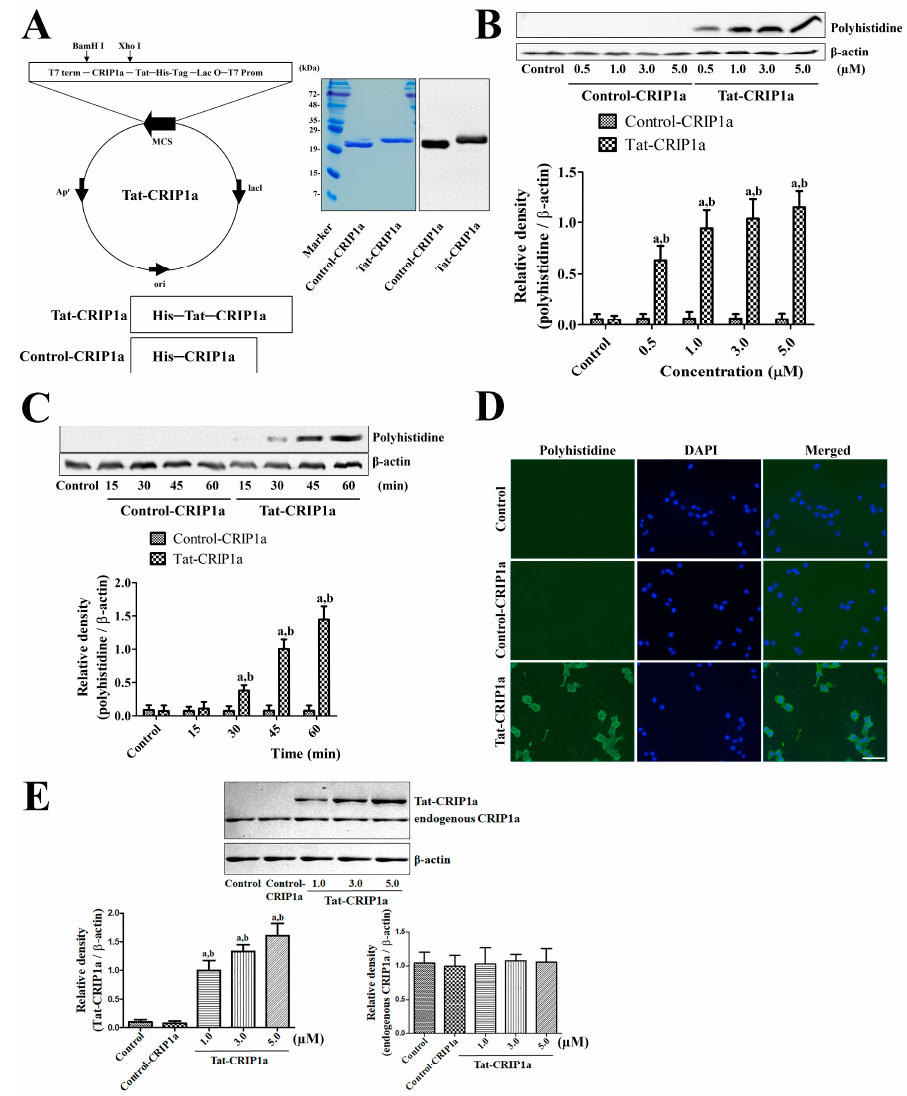
Figure 1. Construction of the control and Tat-CRIP1a fusion proteins and confirmation of e ffi cient delivery into HT22 cells. ( A ) Expression and purification of the His-CRIP1a and Tat-His-CRIP1a proteins were confirmed by Coomassie brilliant blue staining and Western blot analysis with an anti-polyhistidine antibody. ( B ) The delivery of exogenous His-CRIP1a and Tat-His-CRIP1a proteins in various concentrations was evaluated by Western blot for polyhistidine at 60 min after the treatment. ( C ) Time-dependent delivery of 1 µ M His-CRIP1a and Tat-His-CRIP1a proteins was confirmed by Western blot for polyhistidine. Bar graph represents the mean with standard deviation. ( B ) and ( C ) Density of polyhistidine and β -actin bands were analyzed and the data were calibrated using a ratio of polyhistidine / β -actin. A two-way ANOVA test was used to analyze the data followed by a Bonferroni’s post-hoc test ( a p < 0.05, significantly di ff erent from the Control-CRIP1a group; b p < 0.05, significantly di ff erent from the Control group). Data are expressed as mean with standard deviation. ( D ) Visualization of internalized His-CRIP1a and Tat-His-CRIP1a proteins with immunocytochemical staining for polyhistidine at 60 min after treatment. Scale bar = 50 µ m. ( E ) Penetration of exogenous Tat-CRIP1a and expression of endogenous CRIP1a proteins are confirmed by Western blot analysis with an anti-CRIP1a antibody. Data were expressed by ratio of Tat-CRIP1a / β -actin or endogenous CRIP1 / β -actin. One-way ANOVA test was used to analyze the data followed by a Bonferroni’s post-hoc test ( a p < 0.05, significantly di ff erent from the Control-CRIP1a group; b p < 0.05, significantly di ff erent from the Control group). CRIP1a: cannabinoid receptor–interacting protein 1a, Tat-CRIP1a: Tat-His-CRIP1a-treated